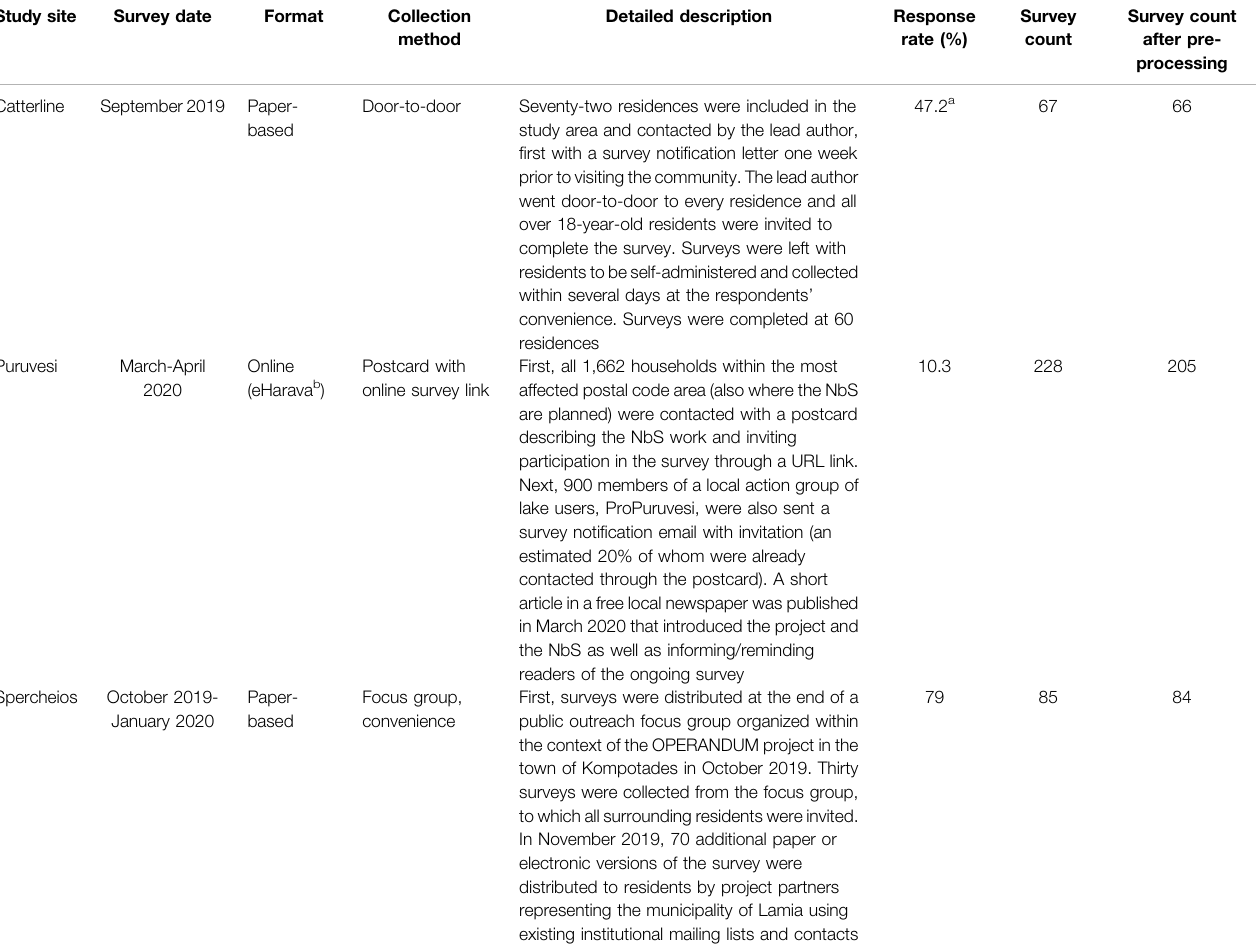
TABLE 1 | Characteristics of the data collection process and outcomes for each of the three study